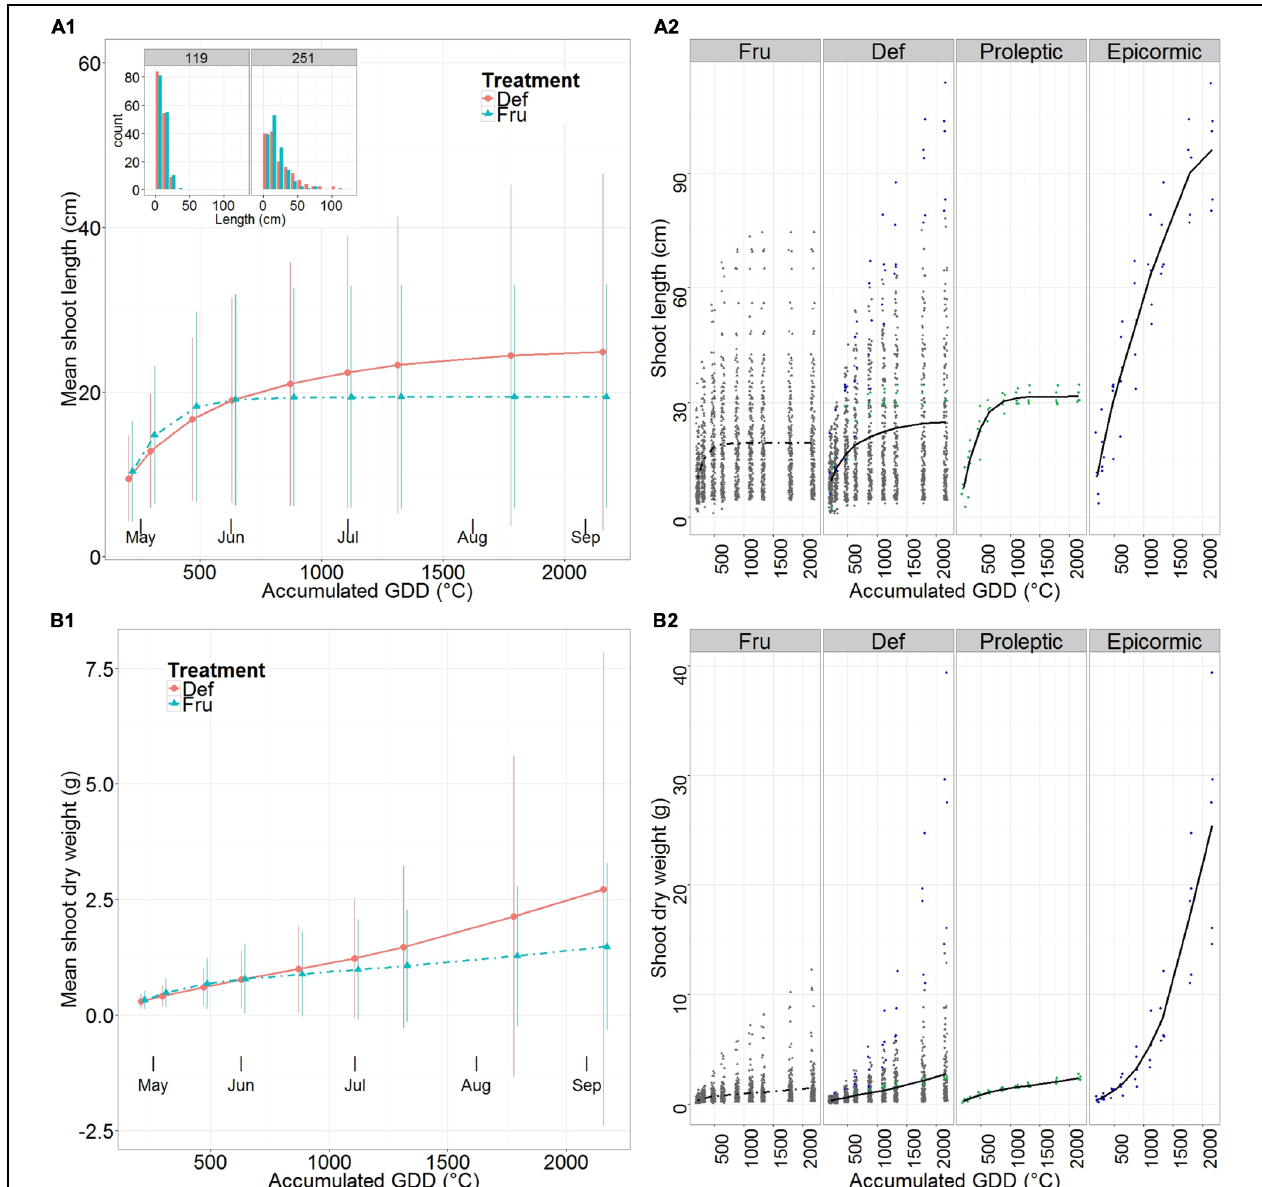
FIGURE 2 | Mean length (A) and predicted shoot dry weight (B) of shoots on fruited (FRU) and defruited (DEF) trees vs. the accumulated growing degree days (GDD) after bloom. A synthetic summary of the mean response for the two treatments (FRU, dotdash; DEF, solid) is given (A1,B1) . Vertical lines indicate standard deviations. The frequency distribution of lengths for DEF and FRU shoots, at the beginning and end of the growing season is shown ( A1 , upper left corner). A comparison between FRU, DEF, and the Max proleptic and epicormic shoots extracted from the DEF population is provided with individual observations in the background (A2,B2) . In (A2,B2) Max proleptic and epicormic shoots are colored respectively in green and